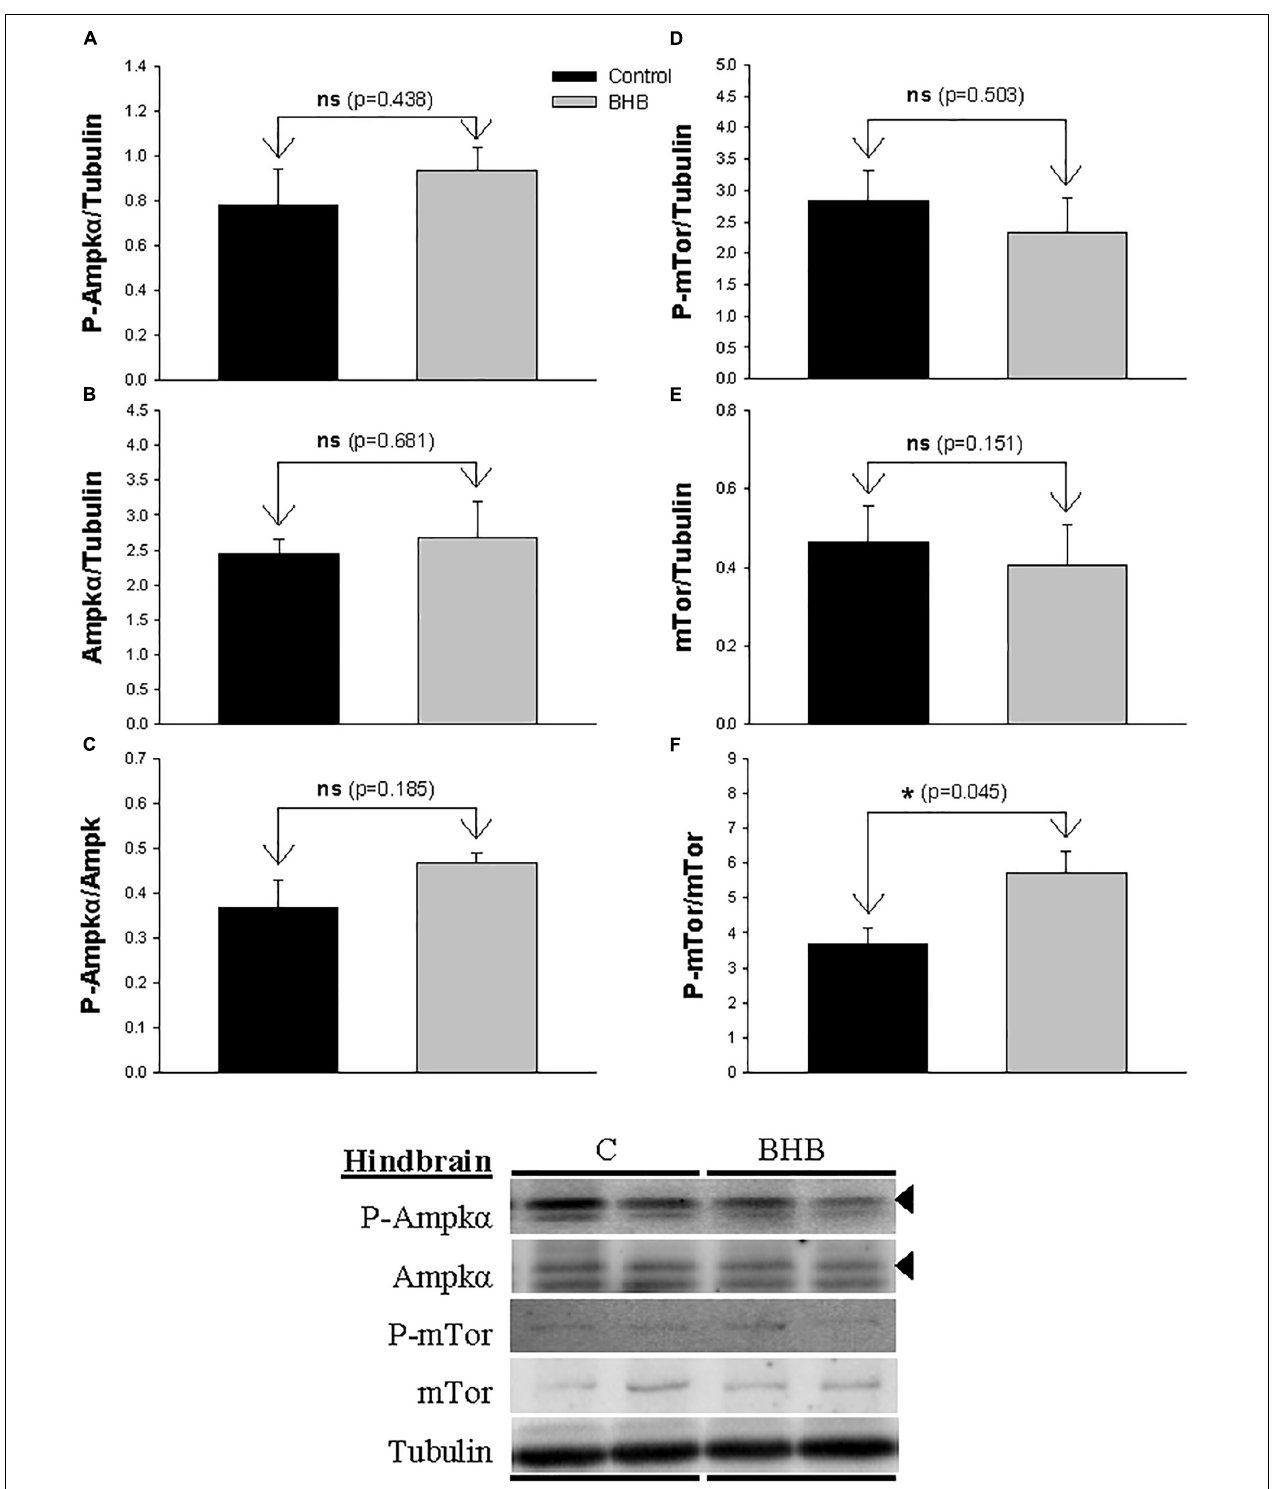
FIGURE 3 | Western blot analysis of Ampk α (A–C) and mTor (D–F) protein levels in hindbrain of rainbow trout 6 h after intracerebroventricular administration of 1 µ L 100 g – 1 body mass of saline solution alone (Control) or containing 0.5 µ mol of β -hydroxybutyrate (BHB). Ten micrograms of total protein were loaded on the gel per lane. Western blots were performed on six individual samples per treatment, and representative blots are shown. Graphs represent the amount of phosphorylated protein (A,D) , the total amount of the target protein (B,E) and the ratio between the phosphorylated protein and the total amount of the target protein (C,F) . Each value is the mean + SEM of n = 6 fish per treatment. ns, not significant difference. ∗ indicates significant differences ( p < 0.05) compared to control group.